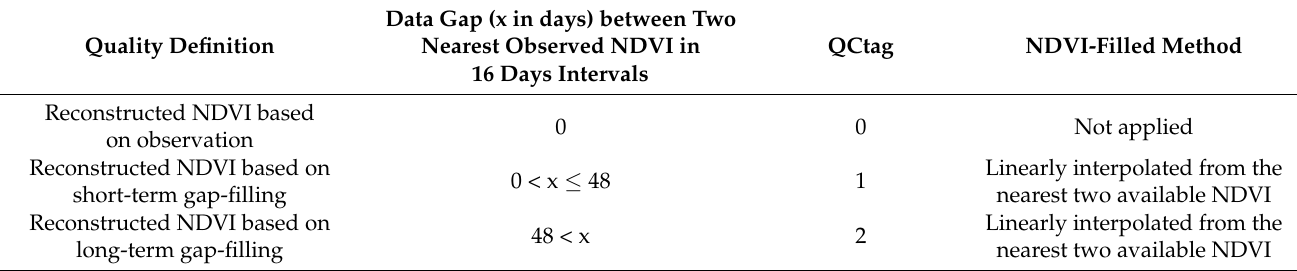
Table 1. Data quality tag of gap-filled and reconstructed NDVI.